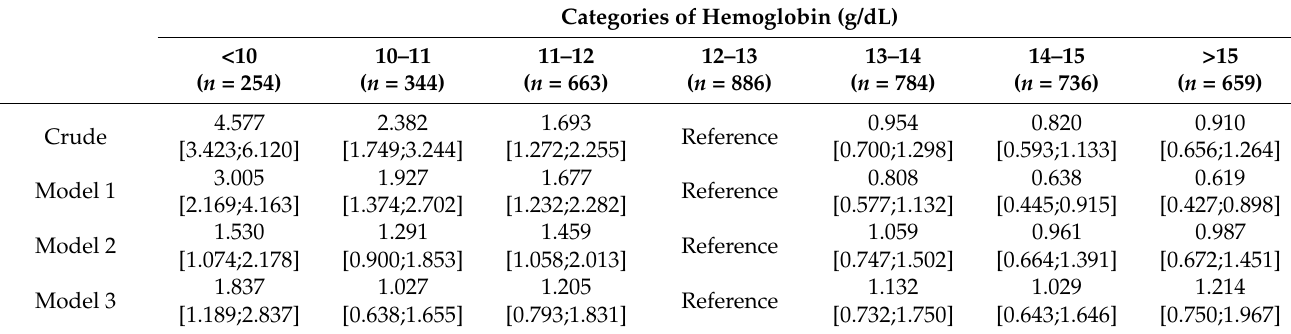
Table 3. Hazard ratio of categories of hemoglobin for renal prognosis of IgA nephropathy with Cox proportional hazard